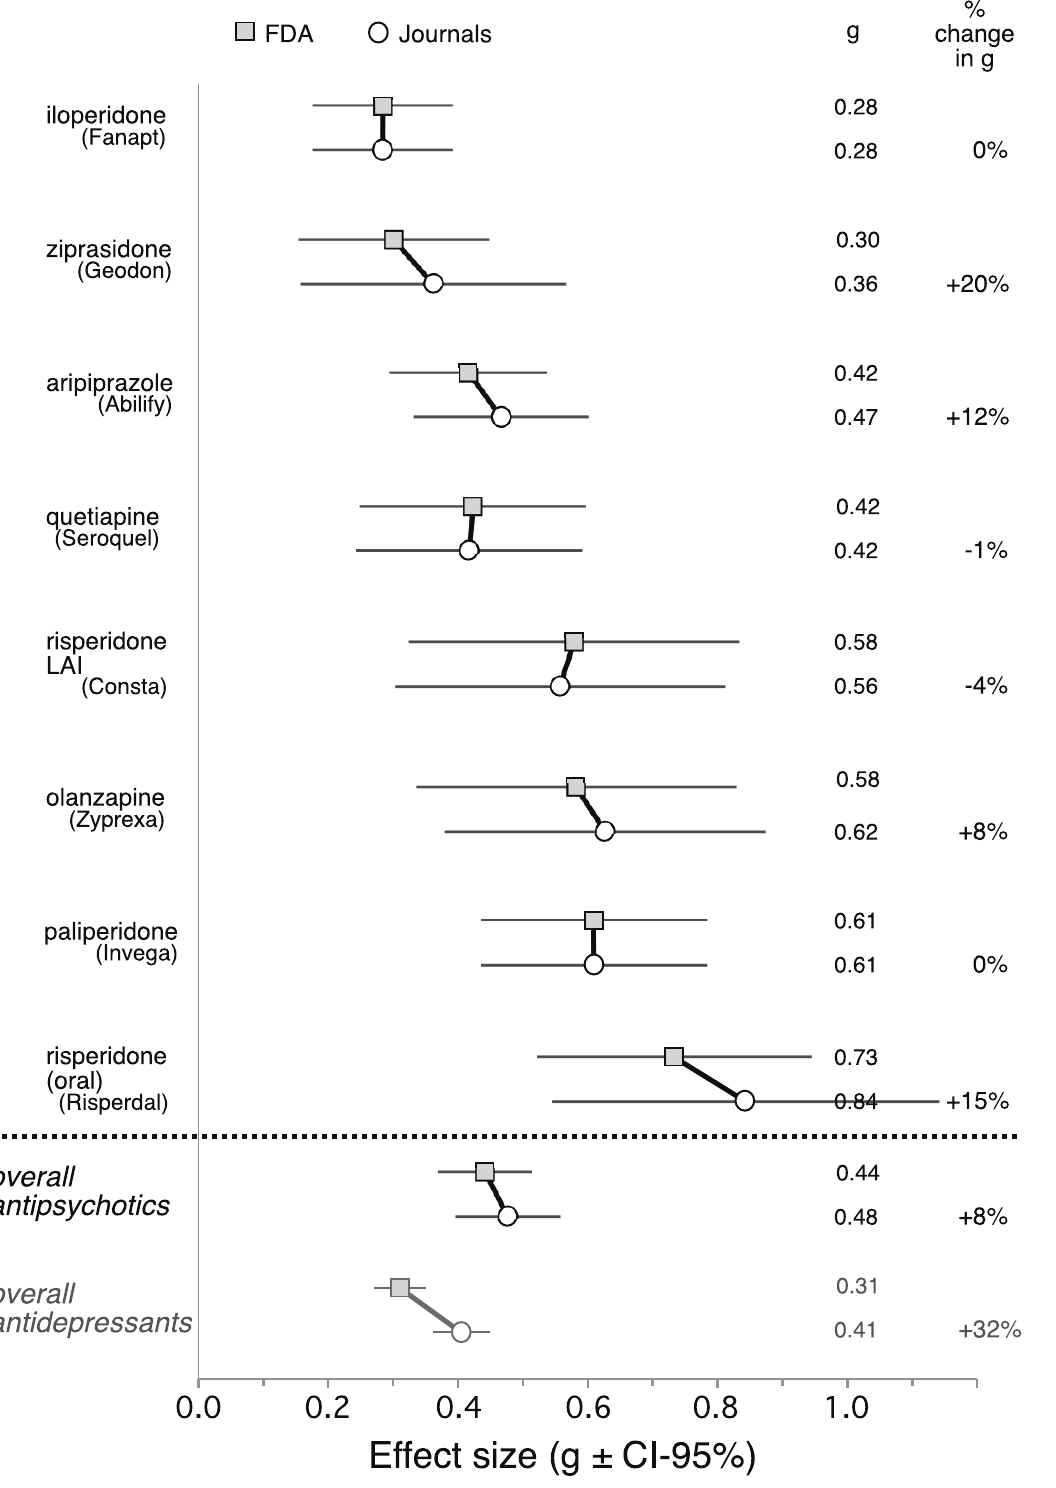
Figure 3. Forest plot of mean weighted effect size (Hedges’s g ) values by drug and data source. The figure is sorted according to the effect size point estimates derived from the FDA data; these are shown with gray-filled squares. The point estimates derived from the corresponding journal articles are shown with open circles. Horizontal lines indicate 95% confidence intervals around the effect size point estimates. The right-hand column shows the percent differences between the FDA-based and the journal-based effect size point estimates. (These percent differences are based on estimates accurate to three decimal places, while the estimates shown are rounded to two decimal places.) The differences ranged from 2 4% to + 20%, depending on the drug. For the entire drug class (labeled ‘‘overall antipsychotics’’), publication bias increased apparent effect size by 8%. To provide context, previously published data on antidepressants [8] are shown at the bottom in gray. Note that the 8% increase with